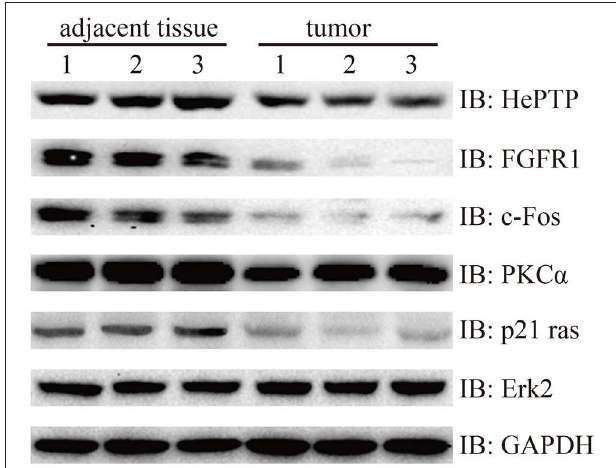
FIGURE 6 | Western blotting detection of MAPK signaling pathway. Lysates from three pairs of bladder cancer and adjacent tissues were subjected to western blotting with antibody to HePTP, FGFR1, c-Fos, PKC α , p21 ras, and Erk2. GAPDH is a reference